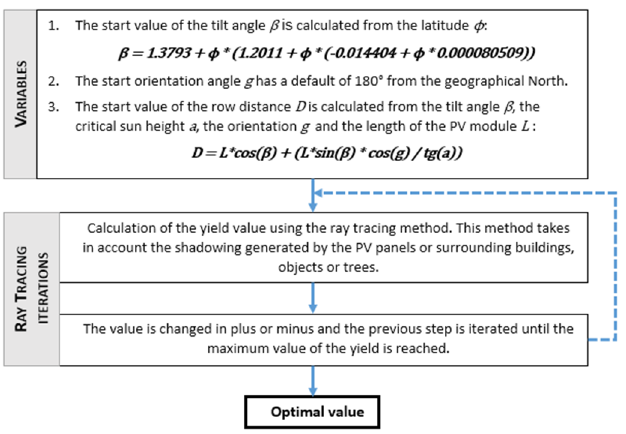
Fig. 6. Optimization work fl ow for PV plant